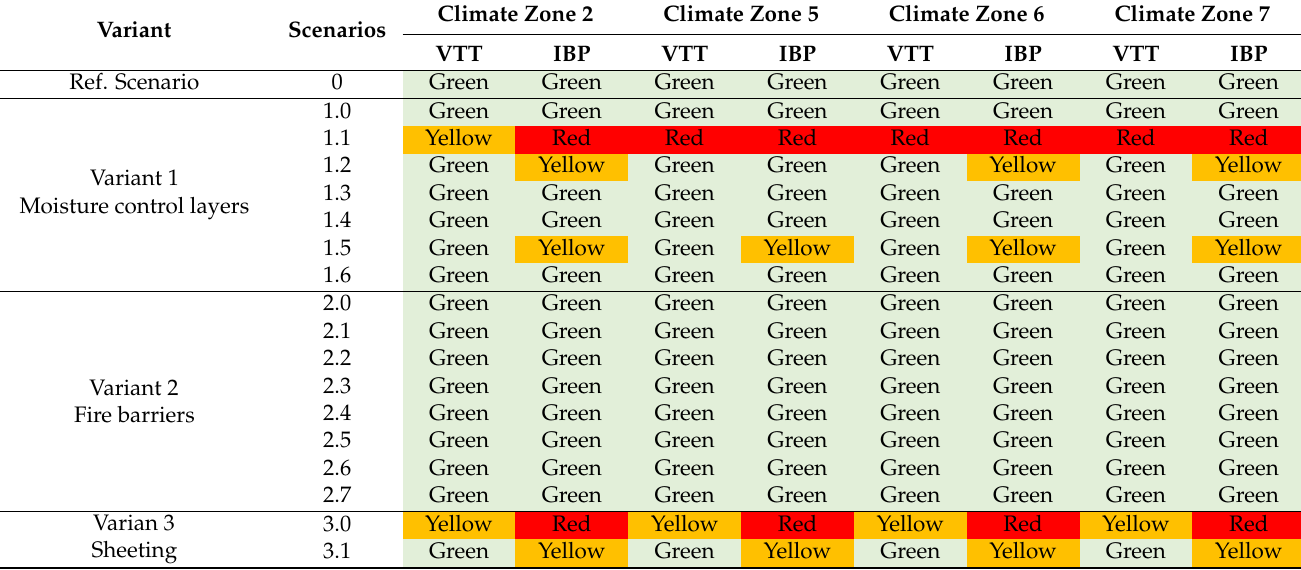
Table 7. Results of the mould growth risk assessment for various mass-timber wall configurations. Variant Ref. Scenario